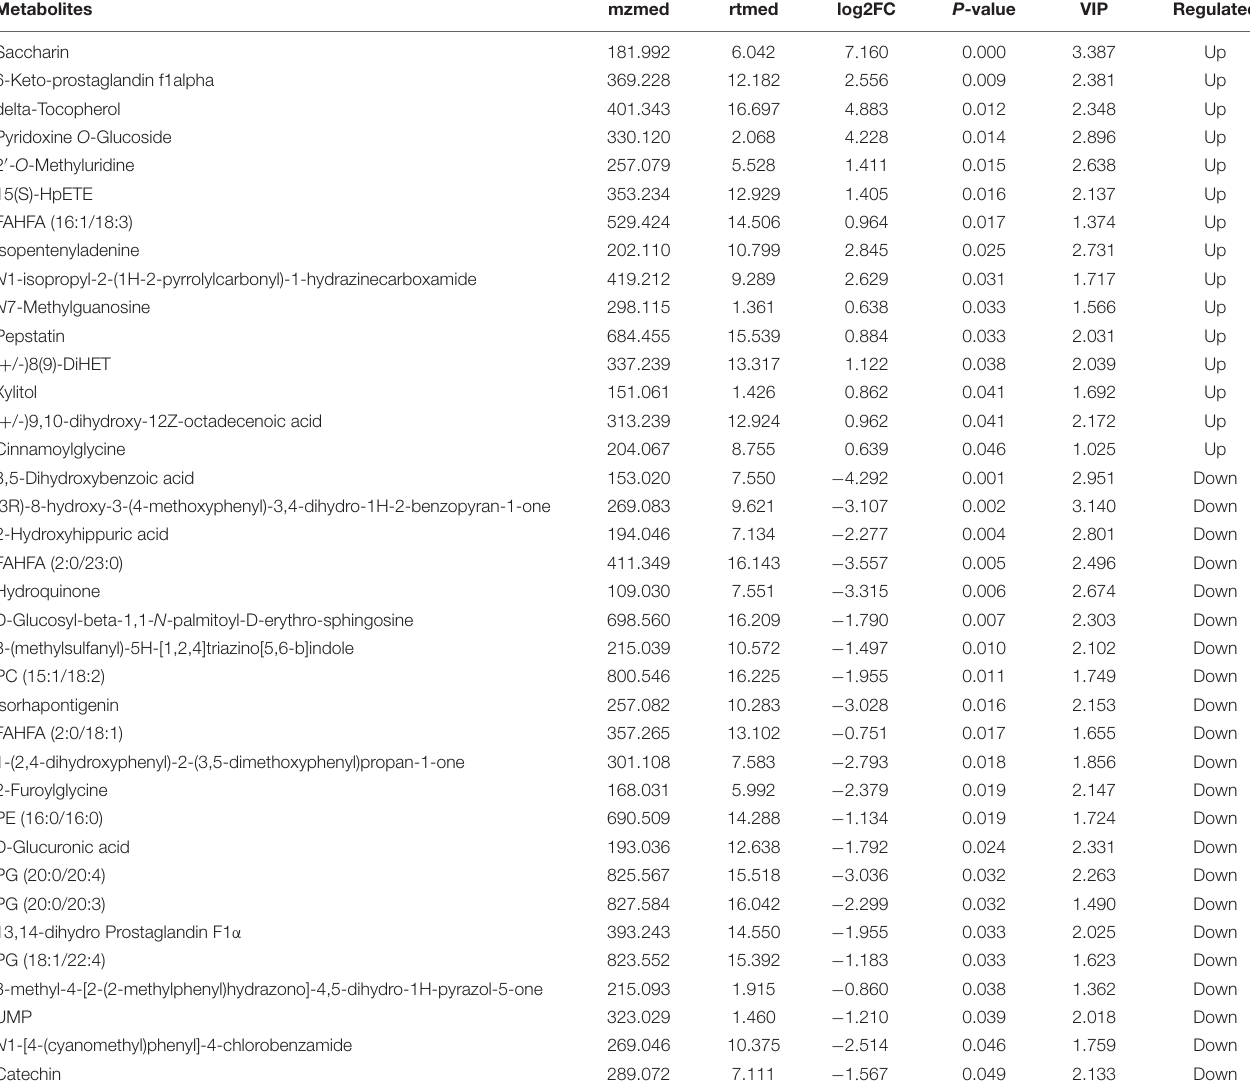
TABLE 6 | Differential metabolites in the rumen of yak calves in the RA and RAS groups. Metabolites mzmed rtmed